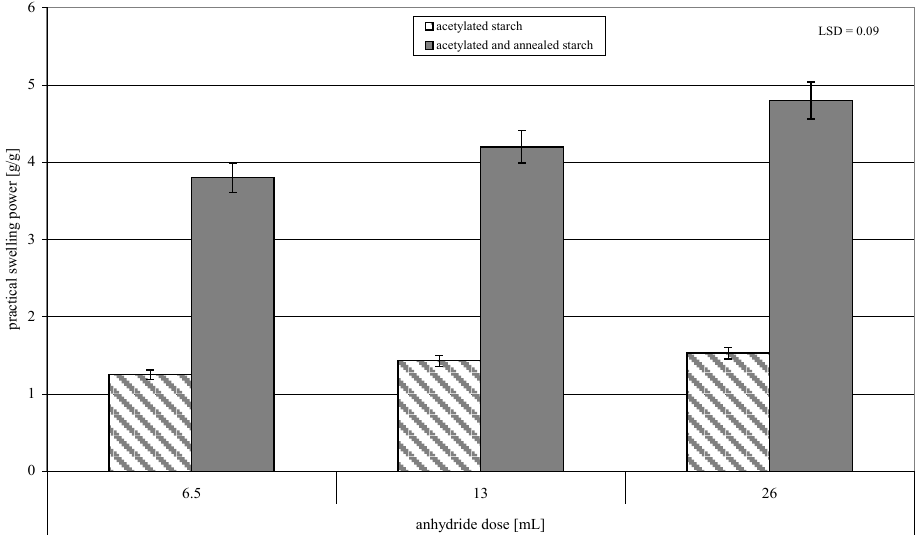
Figure 7. Practical swelling power of acetylated and of acetylated and annealed starch prepara- tions.